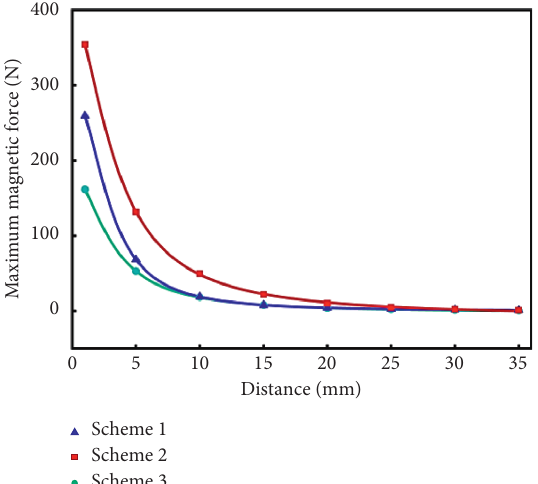
Figure 11: The curve of the relationship between the maximum magnetic force and distance when the valve seat consists of two identical shape tile